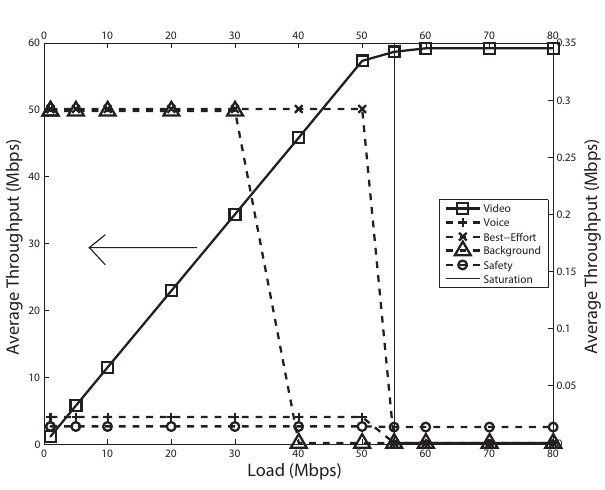
Figure 12. Throughput vs Load